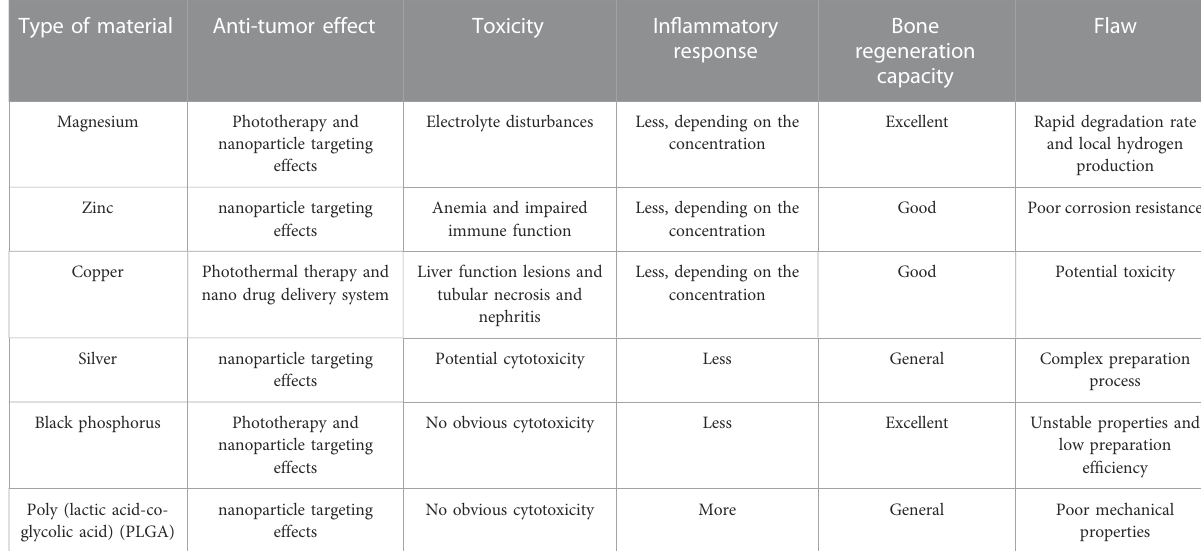
TABLE 1 The Comparison of features of different